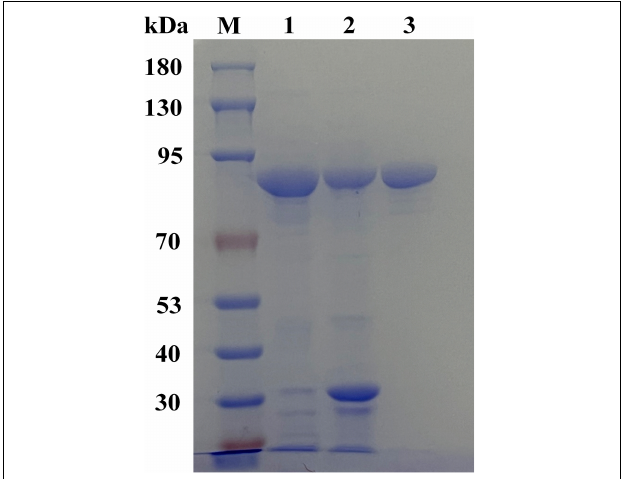
FIGURE 2 | SDS-PAGE analysis of the expression and purification of recombinant NAGaseA. The amount of the loaded protein is 10 µ g. Lane M, protein molecular mass marker, lane 1, crude enzyme preparation of NAGaseA, lane 2, crude enzyme deposit of NAGaseA, lane 3, NAGaseA purified by His6-tag affinity